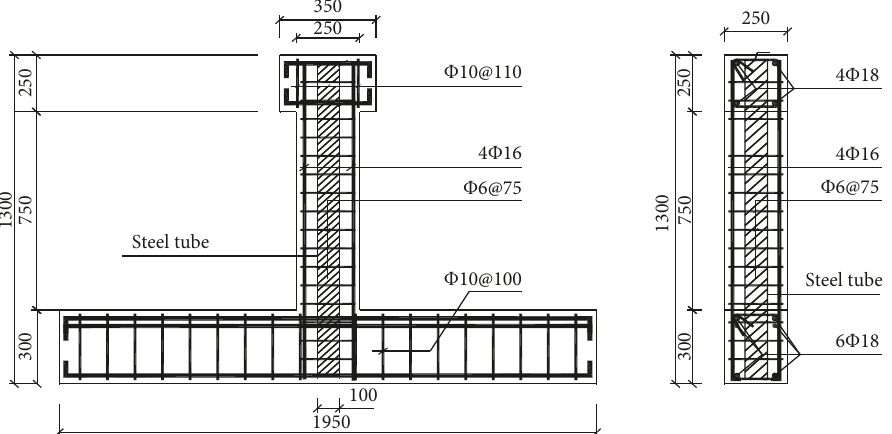
Figure 2: Size and reinforcement of the specimens TSC1, TSC2, and